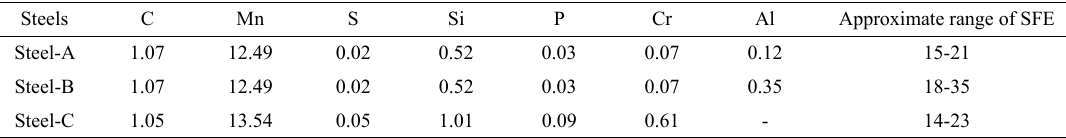
Table 1. Chemical composition and SFE of the steels used in this